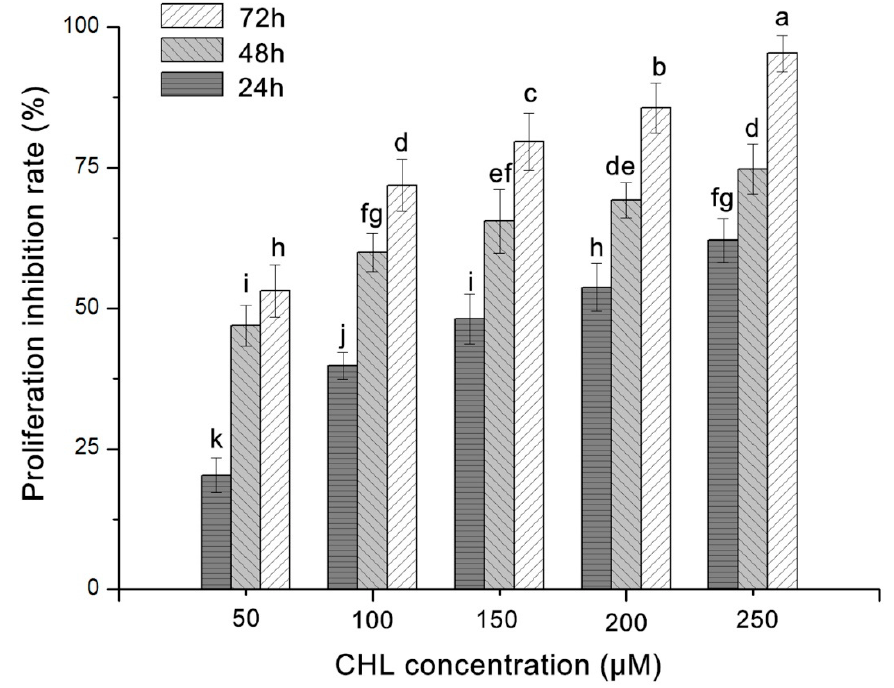
Figure 1. Cytoactivity of chlorfenapyr (CHL) against HepG2 cells under various concentrations at various lengths of time. Distinct letters above the columns indicate significant differences at p ≤ 0.05.